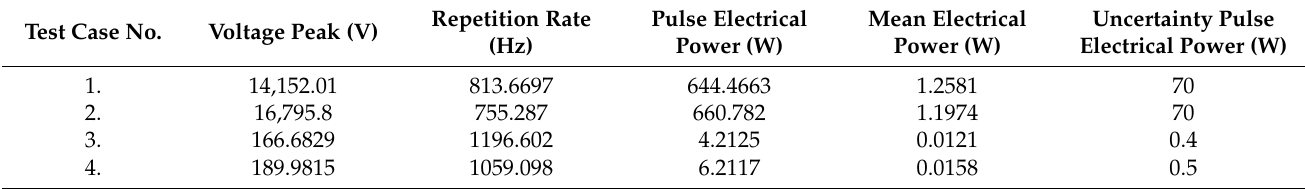
Table 2. Electrical output of plasma actuated test cases.